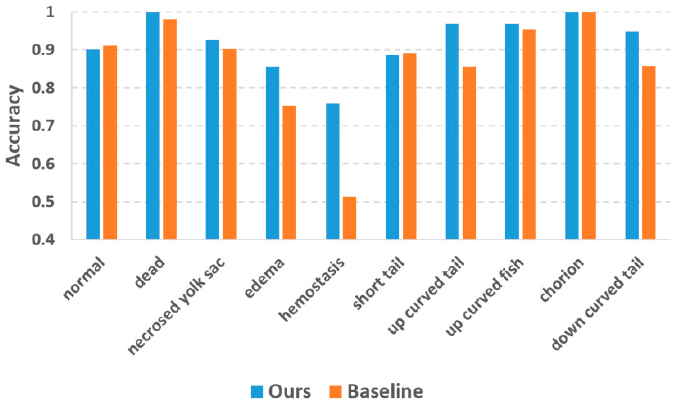
Figure 5. Comparison of classification accuracy between our method and the state-of-the-art baseline method.